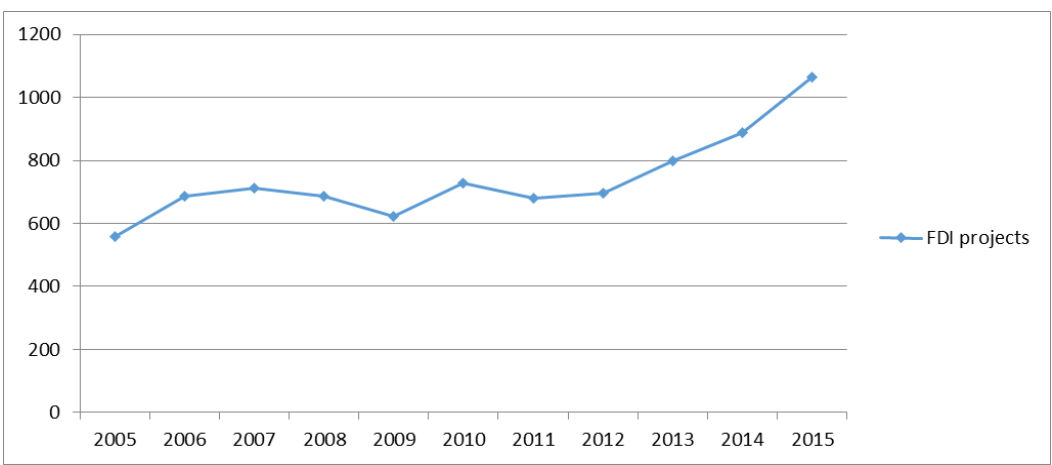
Source: author’s